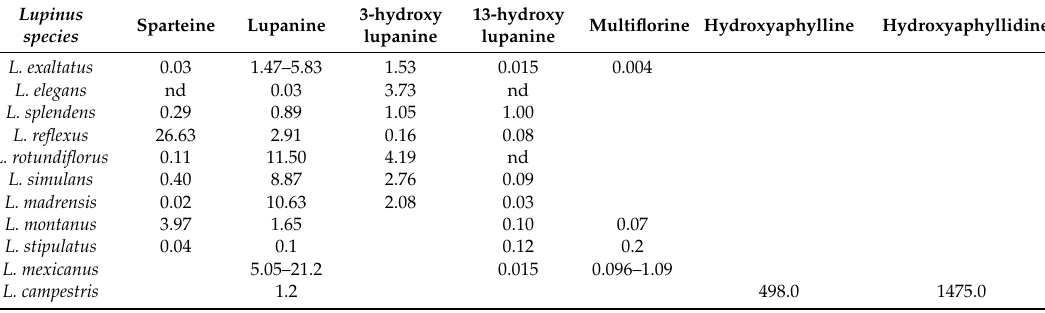
Table 14. Quinolizidine alkaloid content in seeds from wild Mexican lupines (mg of alkaloids / g DM). Lupinus Sparteine species